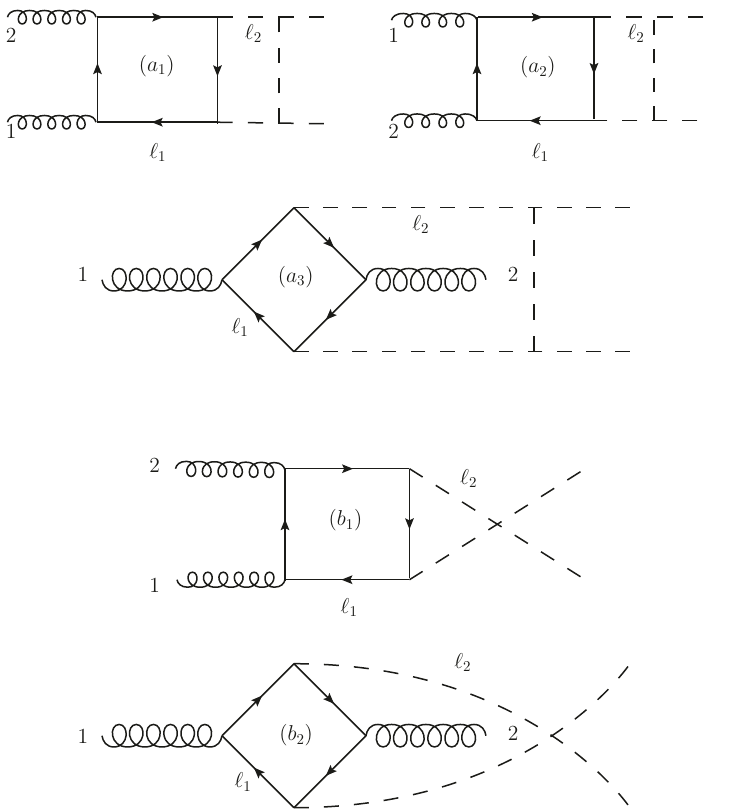
Figure 3 . Non-factorizable two-loop diagrams of classes ( a ) and ( b